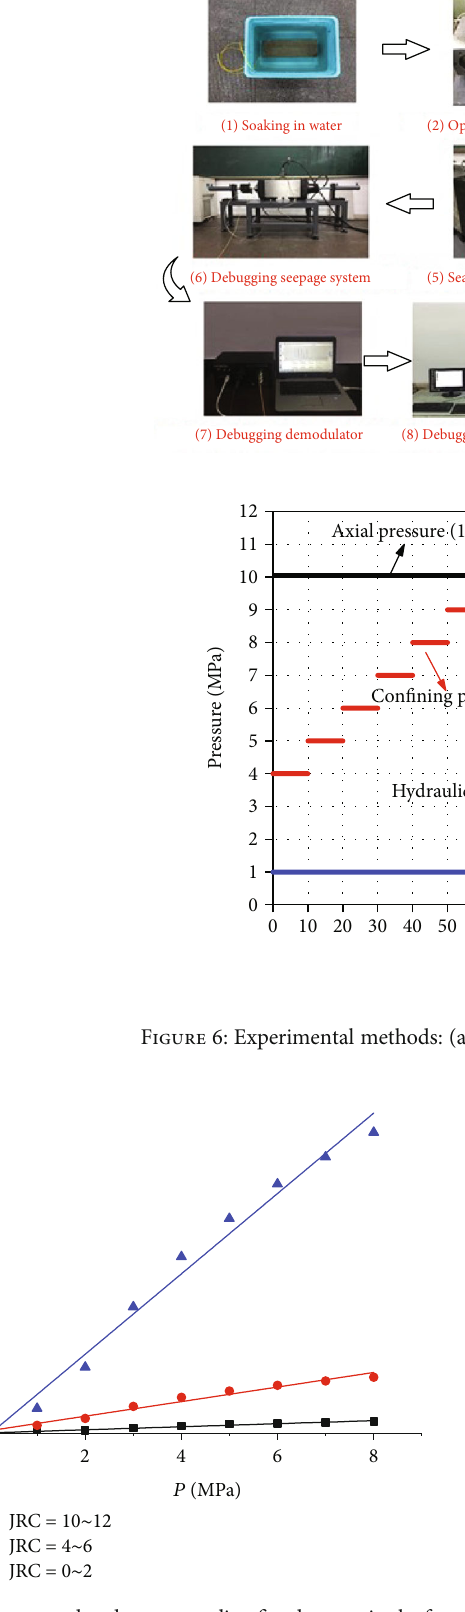
Figure 8: Relationship between hydraulic gradient J and fl ow velocity V at di ff erent JRC